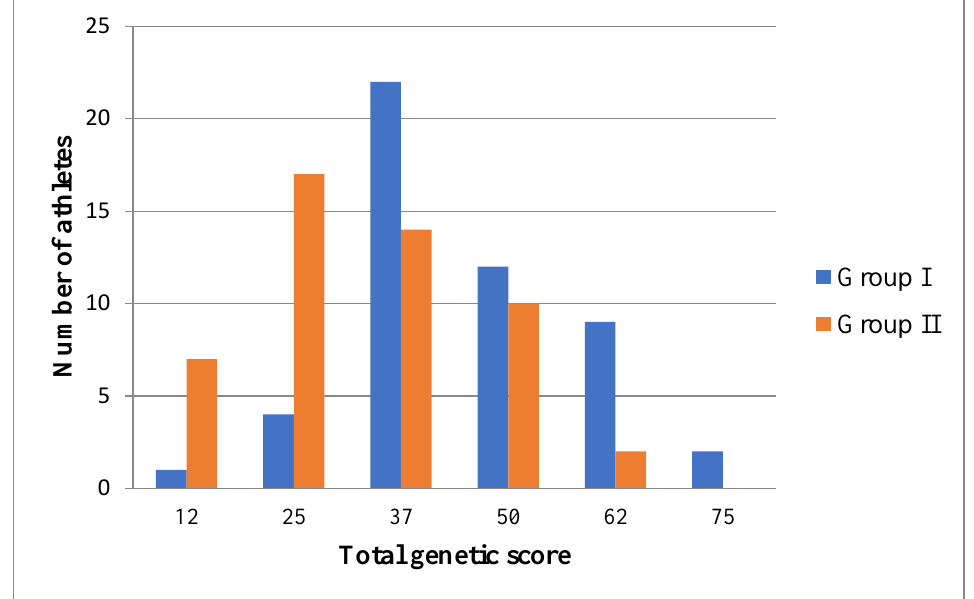
Figure 1. Distribution of the total genetic score established in combatants (n = 100) for the quality of “endurance”, based on the polymorphism of the ACE , BDKRB2 , NOS3 , and PPARGC1A genes.